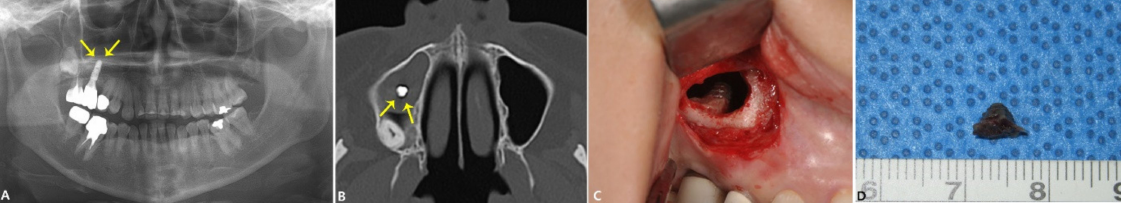
Figure 3. Preoperative radiographic examination of case 3. The panoramic radiograph shows an impacted #18 tooth, submerged #36 and #46 teeth, and a displaced #16i implant protruding into the right maxillary sinus (marked with arrows) ( A ). The CT imaging shows a retention pseudocyst in the right maxillary sinus and slight mucosal thickening of both maxillary sinuses. The apical portion of the protruded #16i implant is visible from the axial view (marked with arrows) ( B ). Intraoperative view of the #16i implant cutting. After careful removal of the inflamed cystic lesions for the sinus, the apical portion of the #16i implant was cut using a high-speed fissure burr ( C ). The 5-mm apical portion of the #16 implant ( D